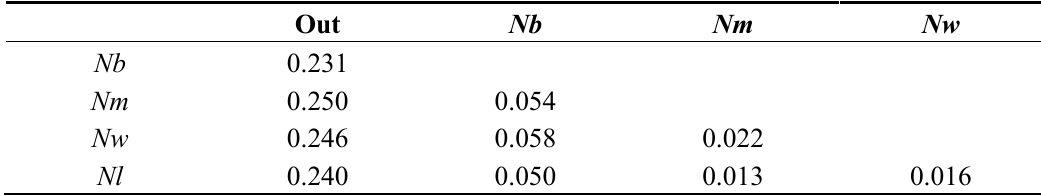
Table 2. Relative to Mongolodiaptomus birulai (out-group), the genetic distance between different populations of Neodiaptomus schmackeri is indicated by the cytochrome c oxidase subunit I (COI) gene. The distance was calculated using the Kimura 2-parameter (transition + transversion) method.